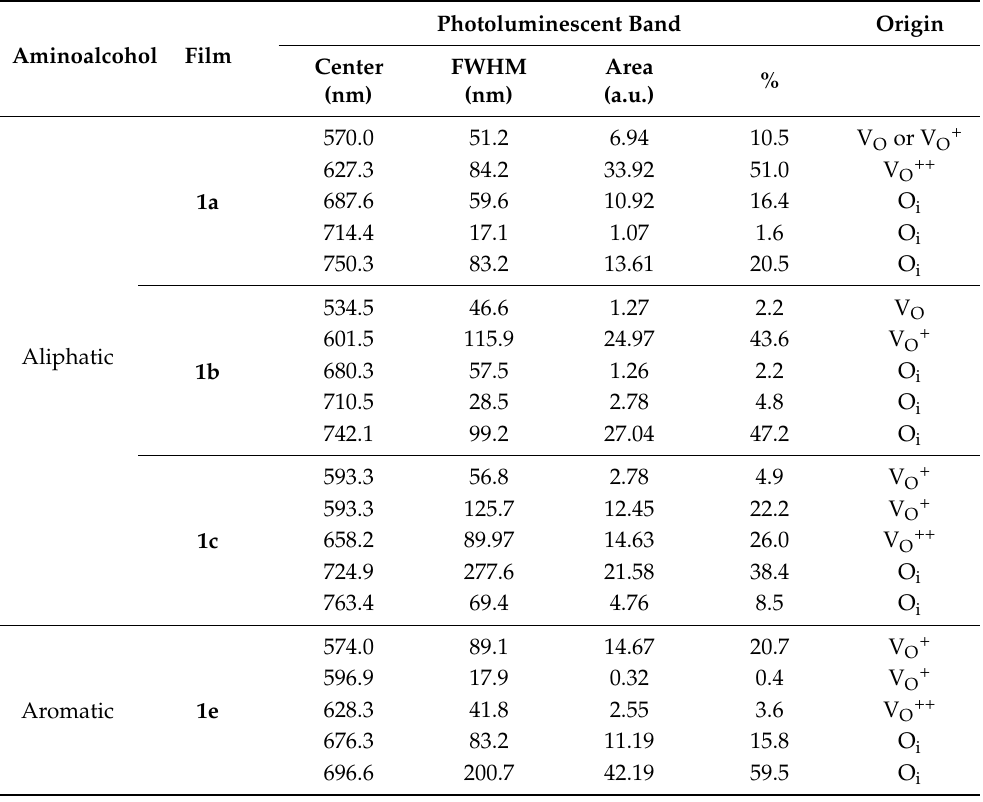
Table 4. Wavelet position, full width at half maximum (FWHM), area, relative weight, and possible assignment of each DLE component (according to [63]) obtained after Gaussian deconvolution for 1a–1c and 1e films annealed at 600 ◦ C. Photoluminescent Band Aminoalcohol Film